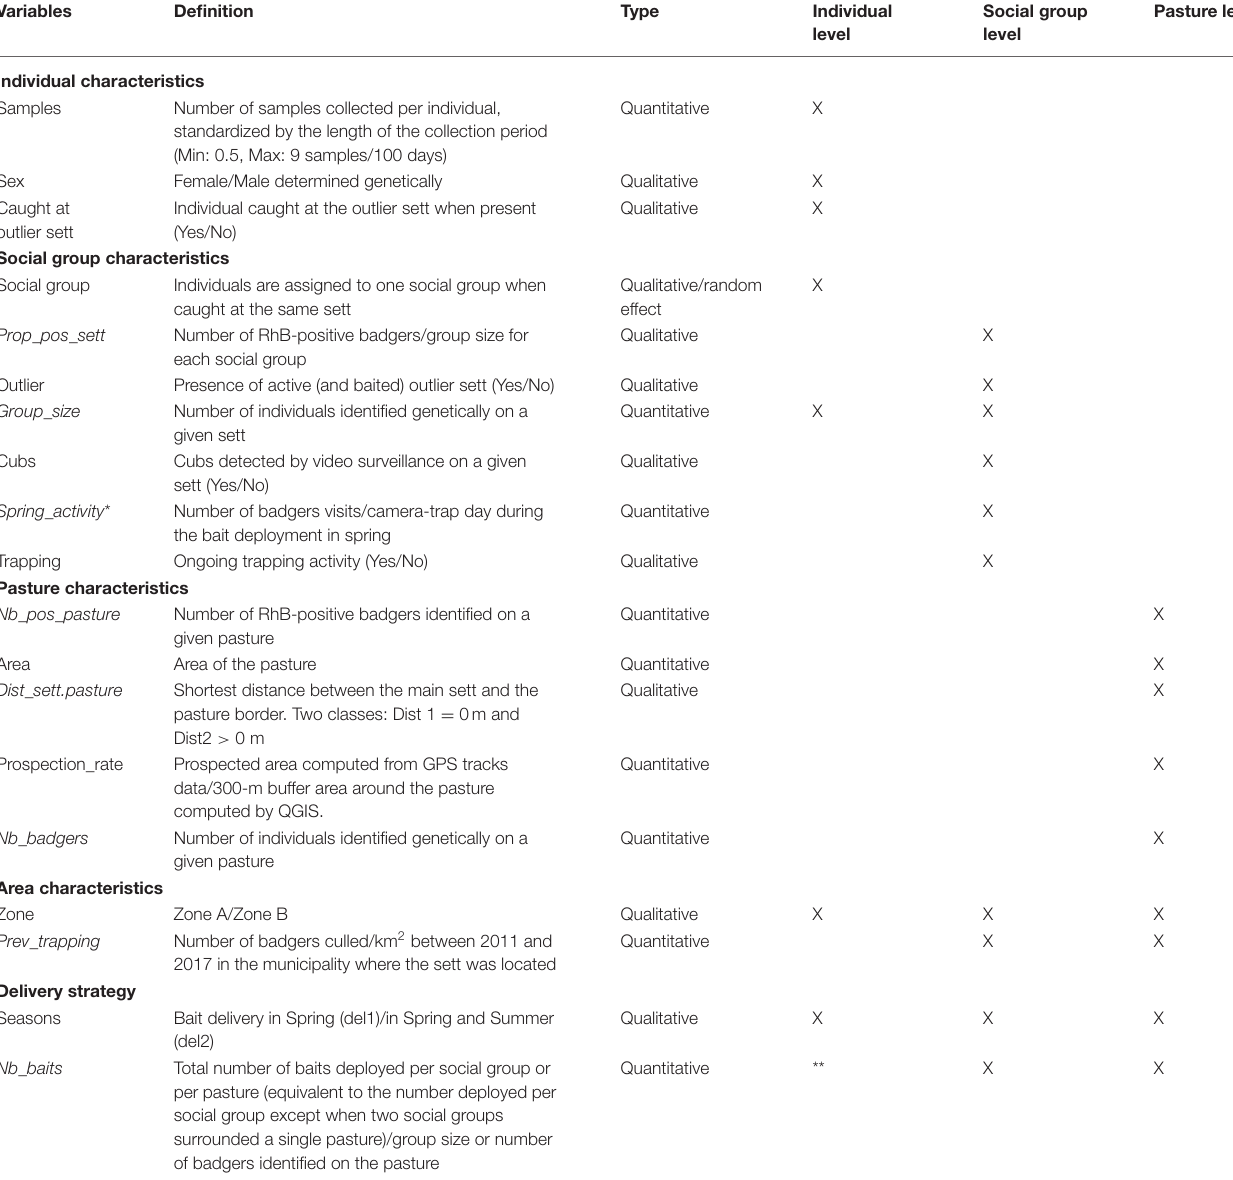
TABLE 1 | Definition and type of the variables used to investigate the bait uptake by badgers at the individual (in a generalized linear mixed model), social group, and pasture levels (in factor analysis with mixed data). Variables Definition Type Individual